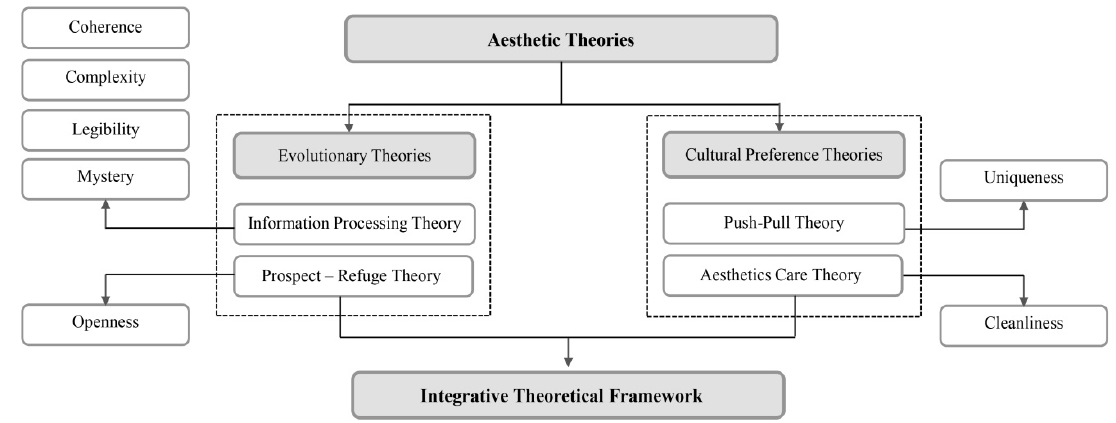
Figure 3. Aesthetic theories framework provide support to visual aesthetic quality variables of urban forests.